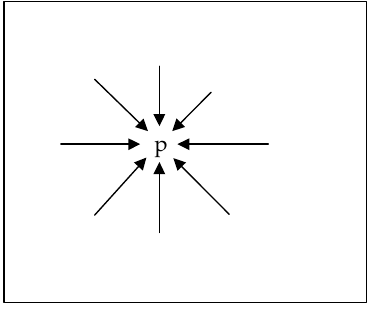
Figure 6. Semi-global aggregation.